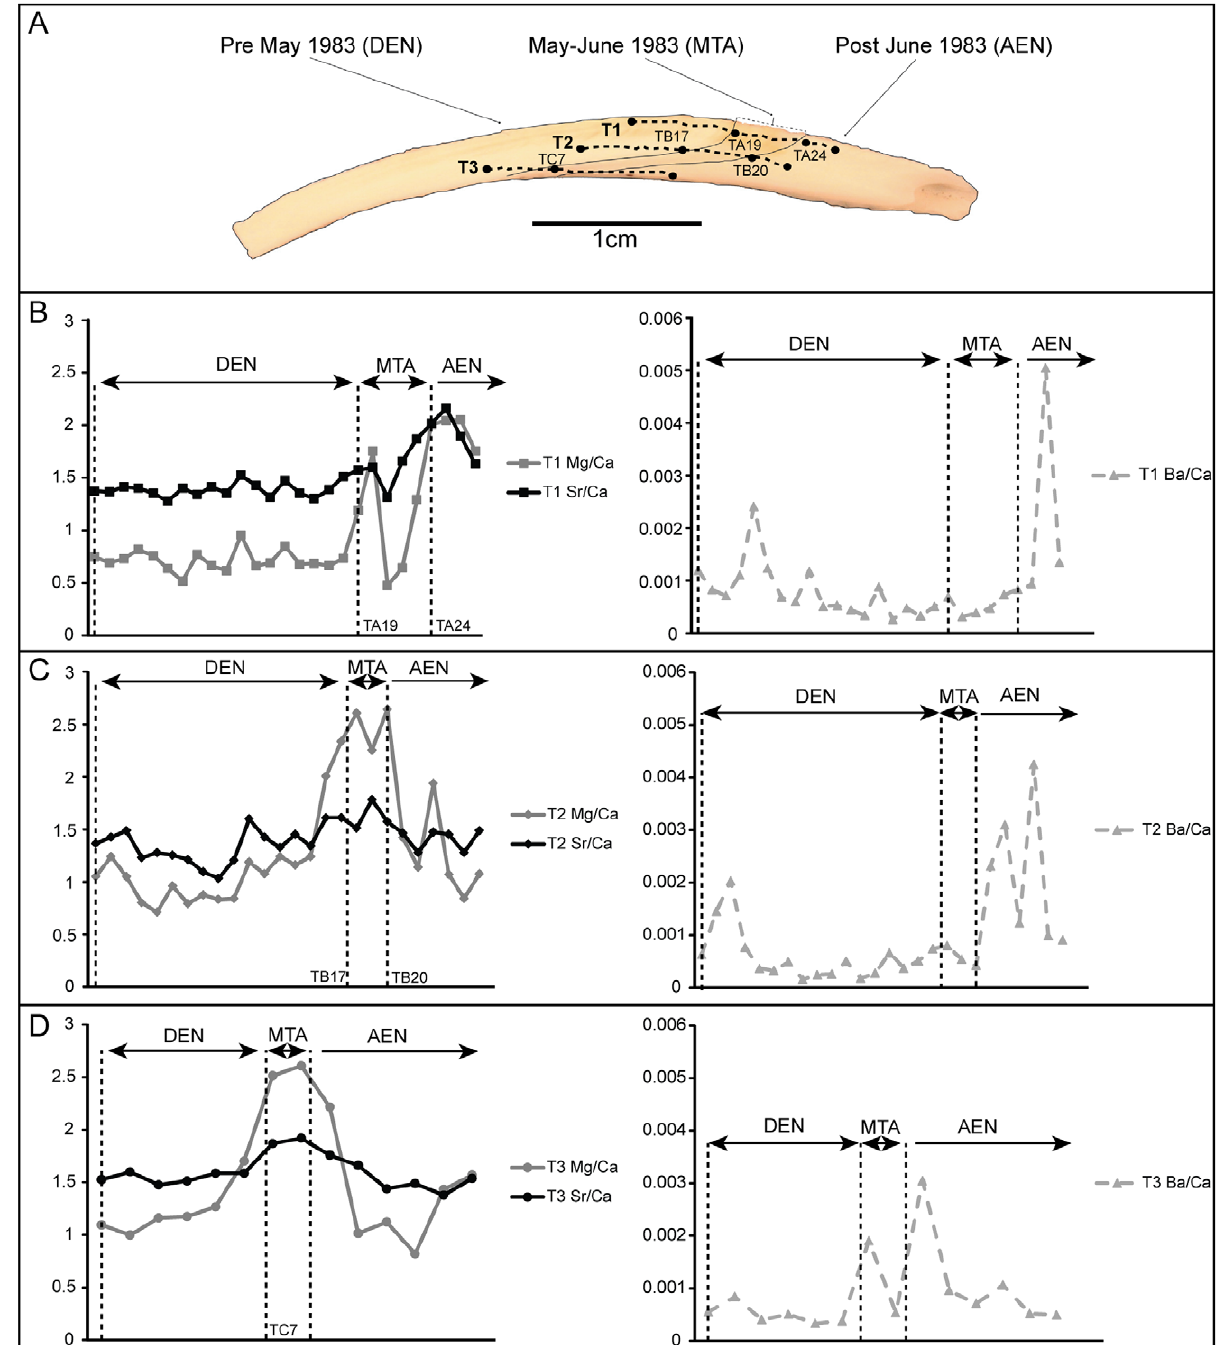
Figure 3. Profiles of Mg/Ca, Sr/Ca and Ba/Ca variability in shell transects of 2TP4-2 specimen during (DEN), at the transition zone – scar (MTA), and after (AEN) the 1982–1983 El Nin˜o event. (A) Image of the shell in longitudinal section showing the location of transects, and some individual measurements as a reference, for each transect. (B) outer layer transect; (C) middle layer transect; (D) inner layer transect. [Sr/Ca - black solid line, Mg/Ca - grey solid line, and Ba/Ca – grey dashed line; number of individual measurements marked by solid squares (transect 1– outer layer), solid diamonds (transect 2– middle layer), and solid circles (transect 3– inner layer) for Mg/Ca and Sr/Ca, and solid triangles for Ba/Ca in all transects; mmol/mol units in all ‘y’ axes; error is , 0.6% for all elemental